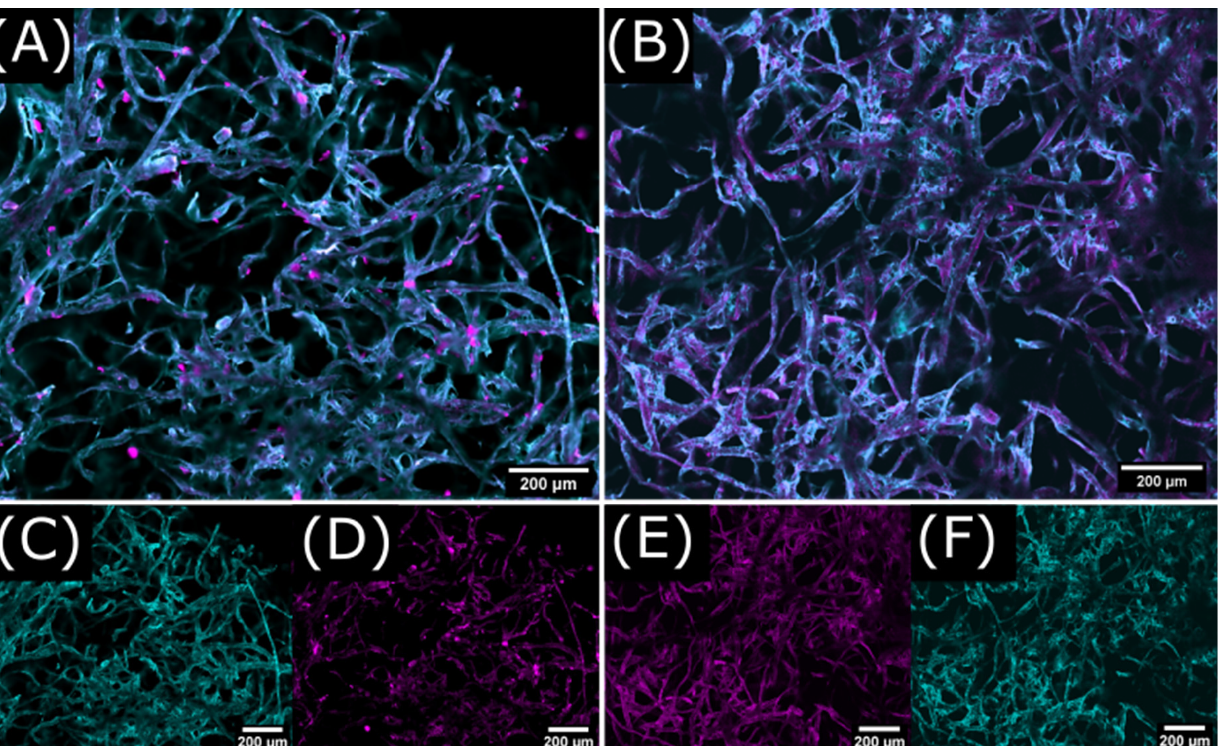
Figure 10. CLSM images with merged rhodamine B and CFW channels for comparison of undegraded keto-HPC ( A ) and strongly degraded keto-HPC ( B ) in lab-made cotton linter paper, both cross-linked with PEI. The separation of rhodamine B (( C ) resp. ( E )) and CFW channel (( D ) resp. ( F )) allows for a better distinction of labeled keto-HPC and stained cellulose fibers.